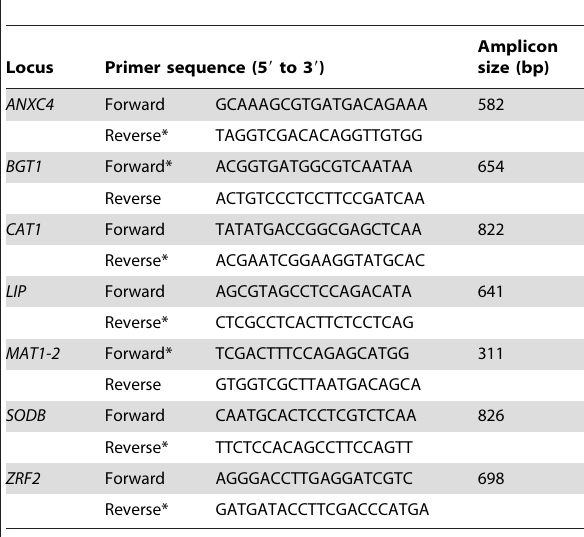
Table 1. Primers used for MLST genotyping of Aspergillus fumigatus in a multiplex